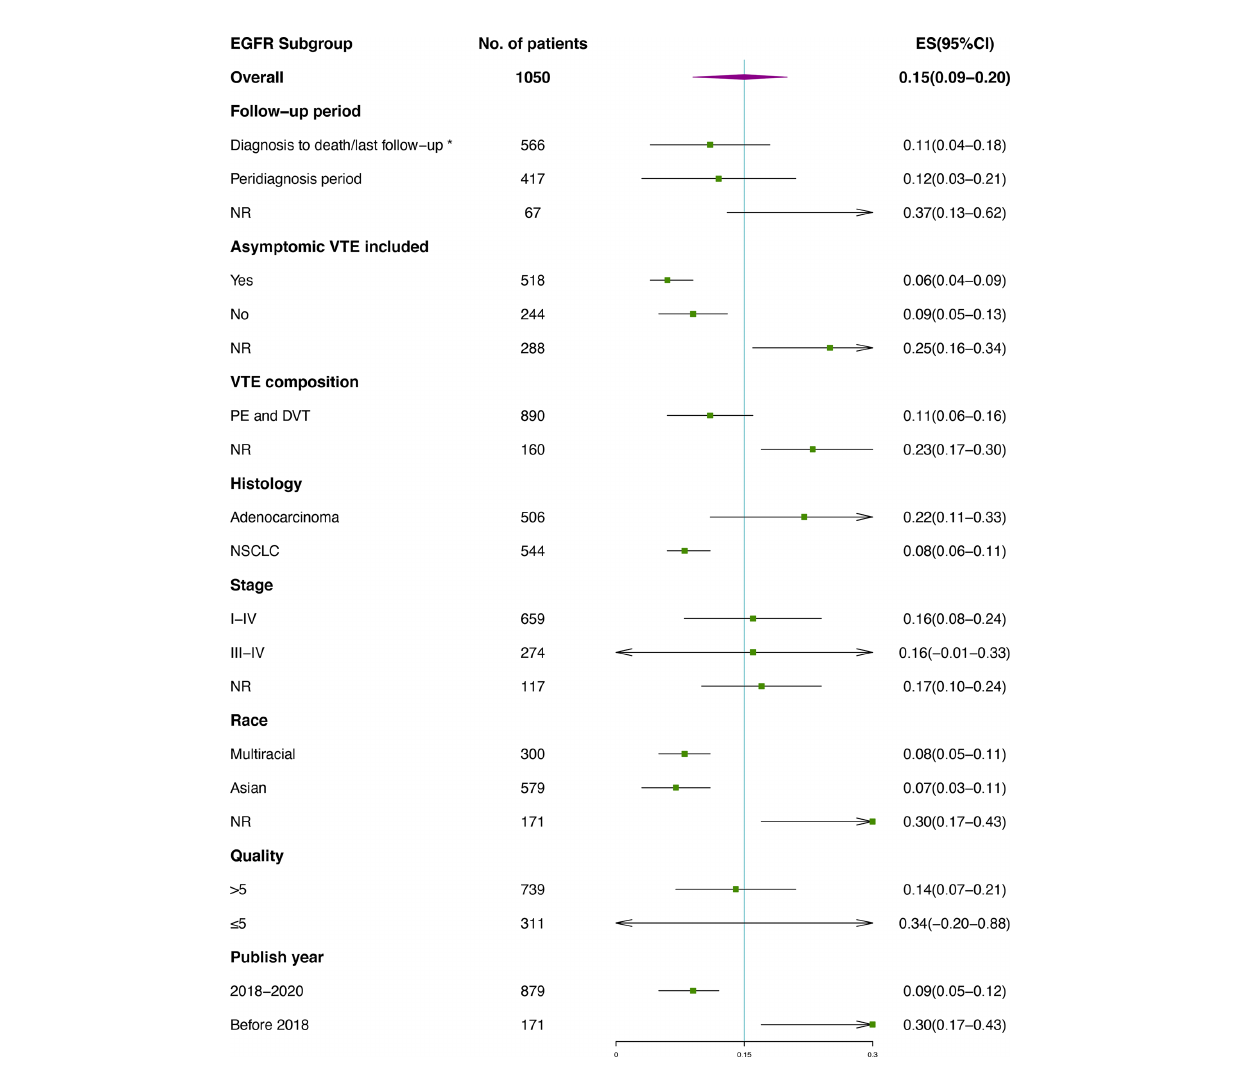
FIGURE 5 | Subgroup analysis of VTE incidence in EGFR mutant patients. *Studies containing VTEs that occurred prior to diagnosis were also